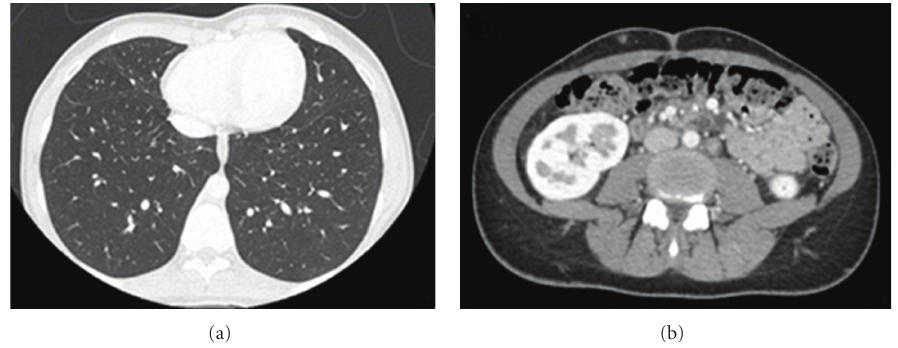
Figure 1: Computed tomography showing multiple pulmonary nodules (a) and retroperitoneal lymph nodes (b).